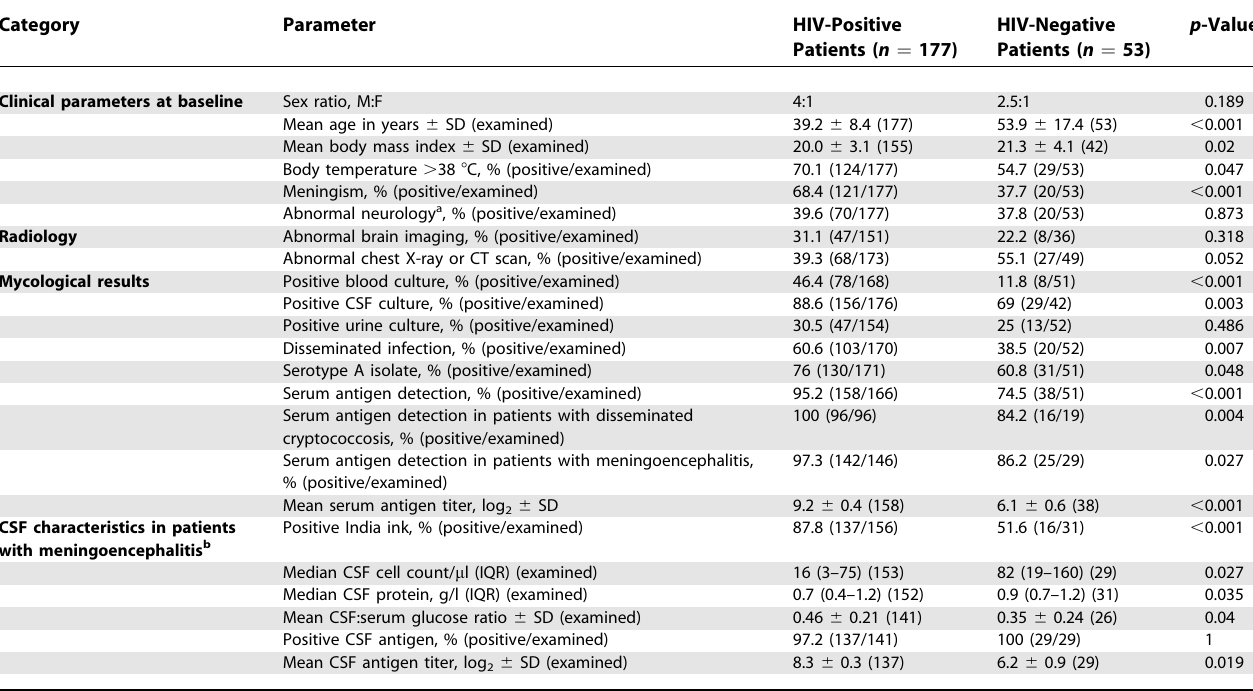
Table 1. Baseline Clinical, Radiological, and Mycological Characteristics in 230 Adult Patients with Culture-Confirmed Cryptococcosis According to HIV